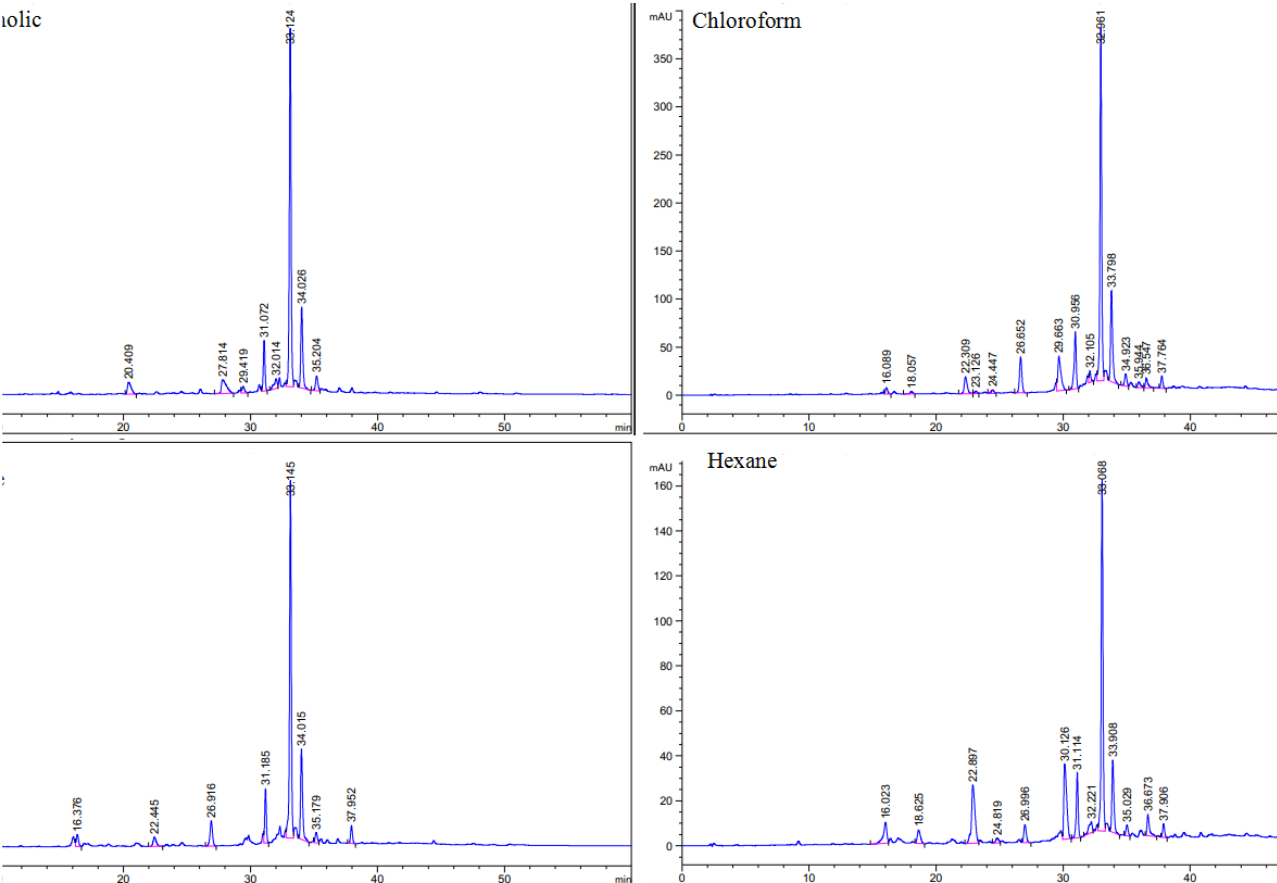
FIGURE 4 - HPLC-DAD finger printing of A) methanolic fraction, B) chloroform fraction C) Ethylacetate fraction and D) n -Hexane